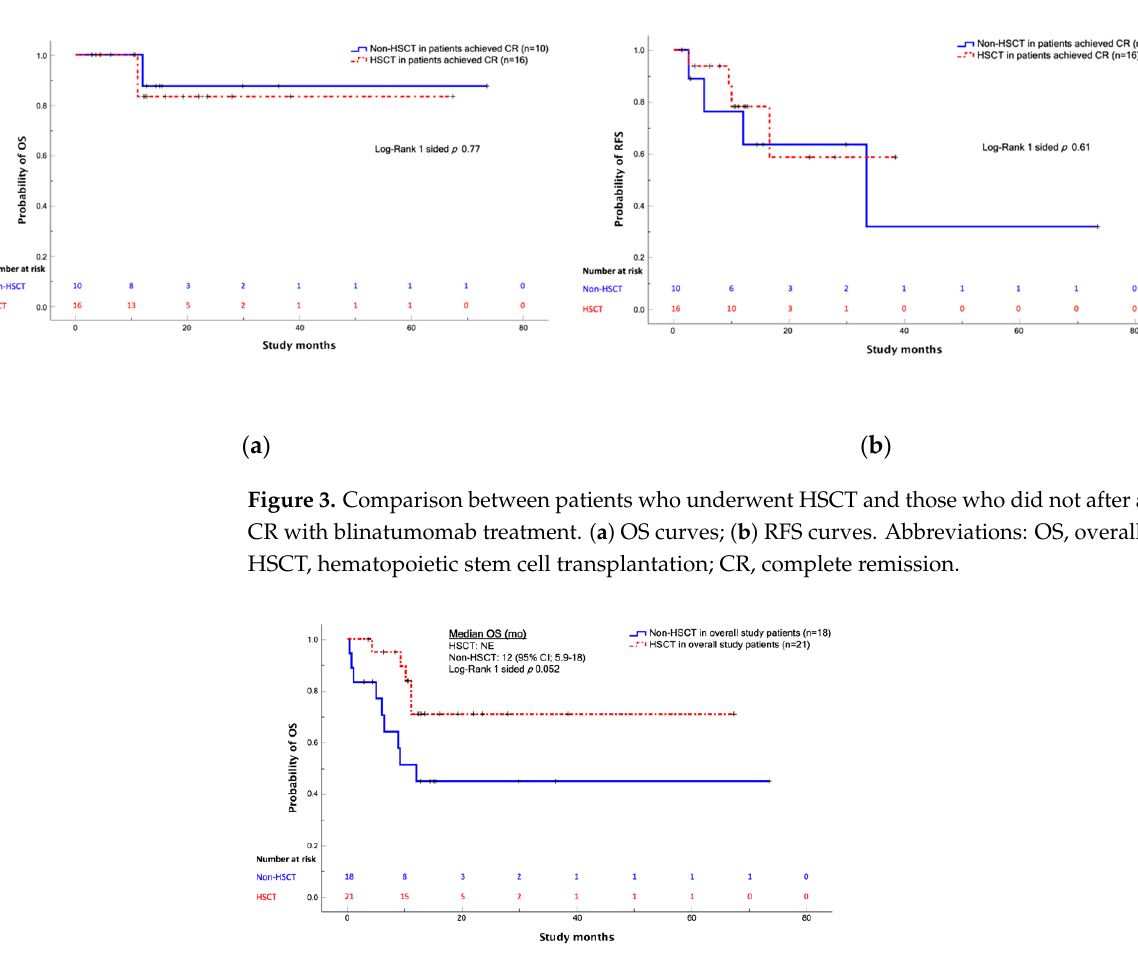
Figure 4. Kaplan-Meier analysis of the OS comparing patients who underwent HSCT and those who did not. The difference was not significant; log-rank one-sided p = 0.052. Abbreviations: OS, overall survival; mo, months; HSCT, hematopoietic stem cell transplantation; NE, not evaluable.